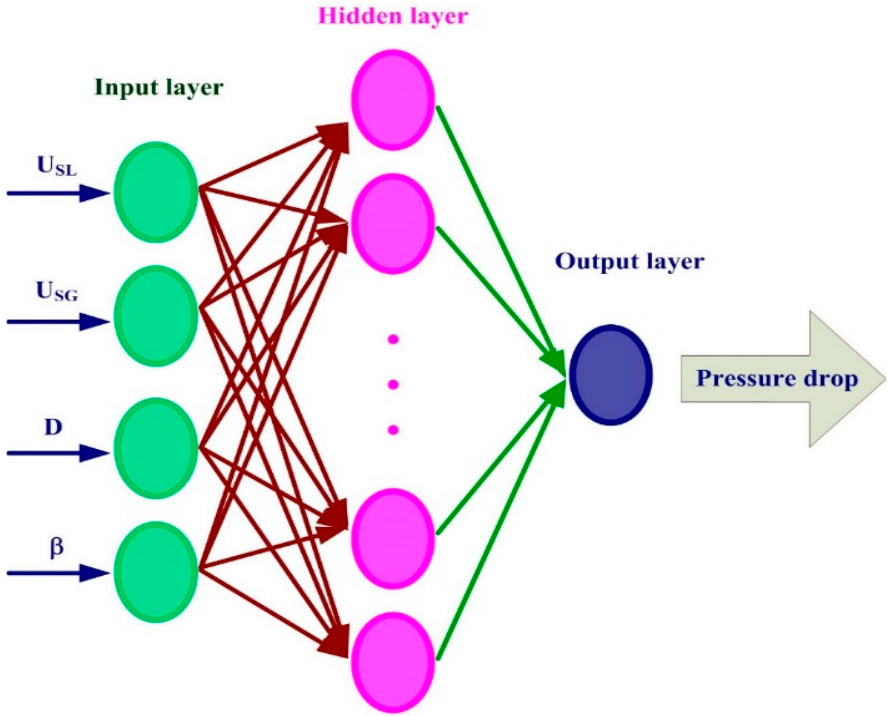
Figure 1. Diagram of the three ‐ layer ANN model developed in the present